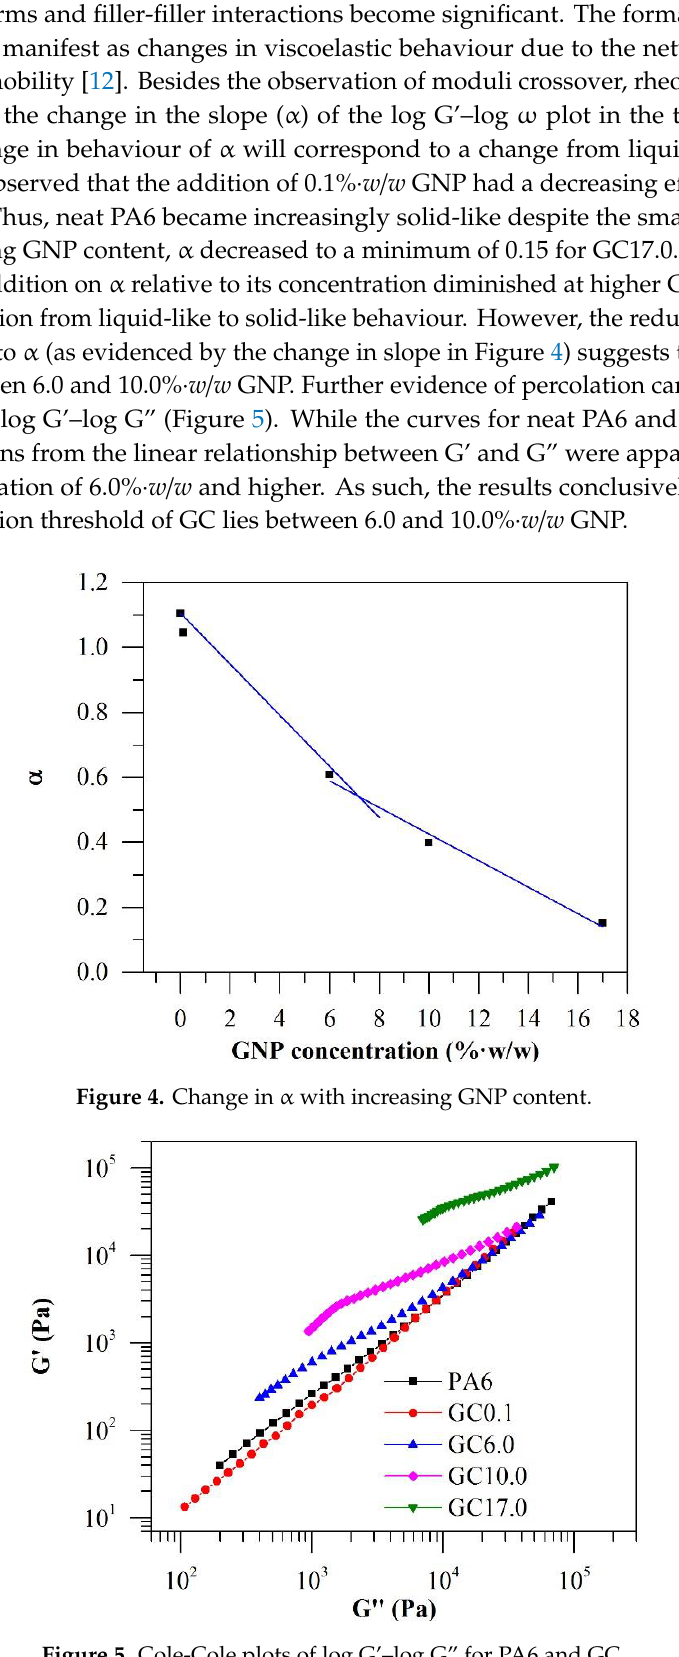
Figure 5. Cole-Cole plots of log G’–log G” for PA6 and GC.